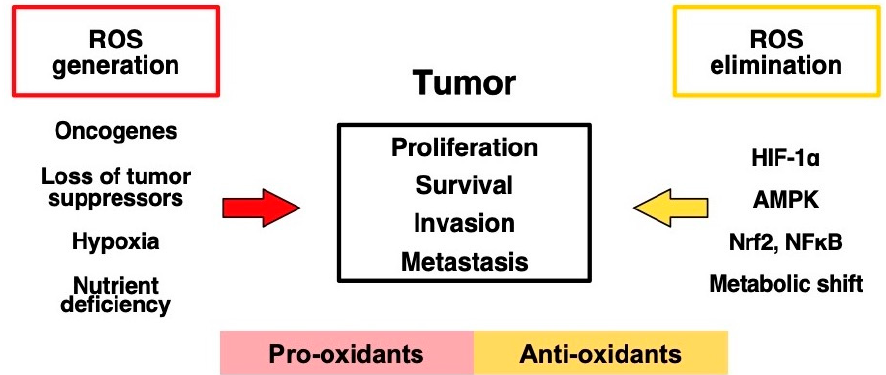
Figure 1. Cellular redox homeostasis in cancerous cells. Cancer cells display enhanced ROS pro- duction due to oncogene activation or loss of tumor suppressors and a relative oxygen and nutrient deficiency. To combat the onset of oxidative stress, cancer cells employ different defense mechanisms by activating transcription factors (HIF1 α , Nrf2, NF κ B) to enhance the transcription of pro-angiogenic and antioxidant genes. In addition, these factors also modulate metabolic gene expression to favor a metabolic shift to support the increased need for biomolecules and antioxidant molecules. AMPK is a sensor of nutrient status and can also support metabolic reorientation. Taken together, these pro- and antioxidant components promote tumor proliferation, survival, invasion, and metastasis [3]. ROS: reactive oxygen species; HIF1 α : hypoxia inducible factor 1 alpha; AMPK: AMP-activated protein kinase; Nfr2: Kelch-like ECH-associated protein 1 (Keap1)-Nuclear factor erythroid 2-related factor 2; NF κ B: nuclear factor kappa-light-chain-enhancer of activated B